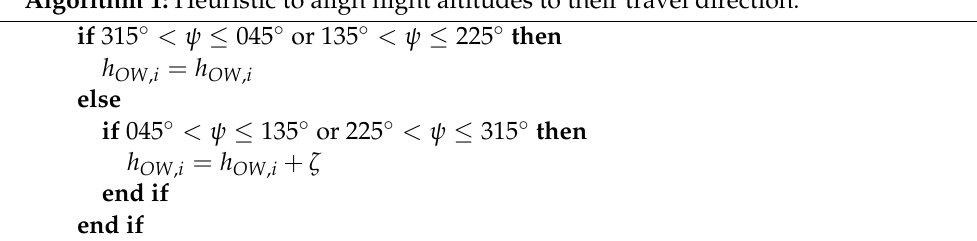
Algorithm 1: Heuristic to align flight altitudes to their travel